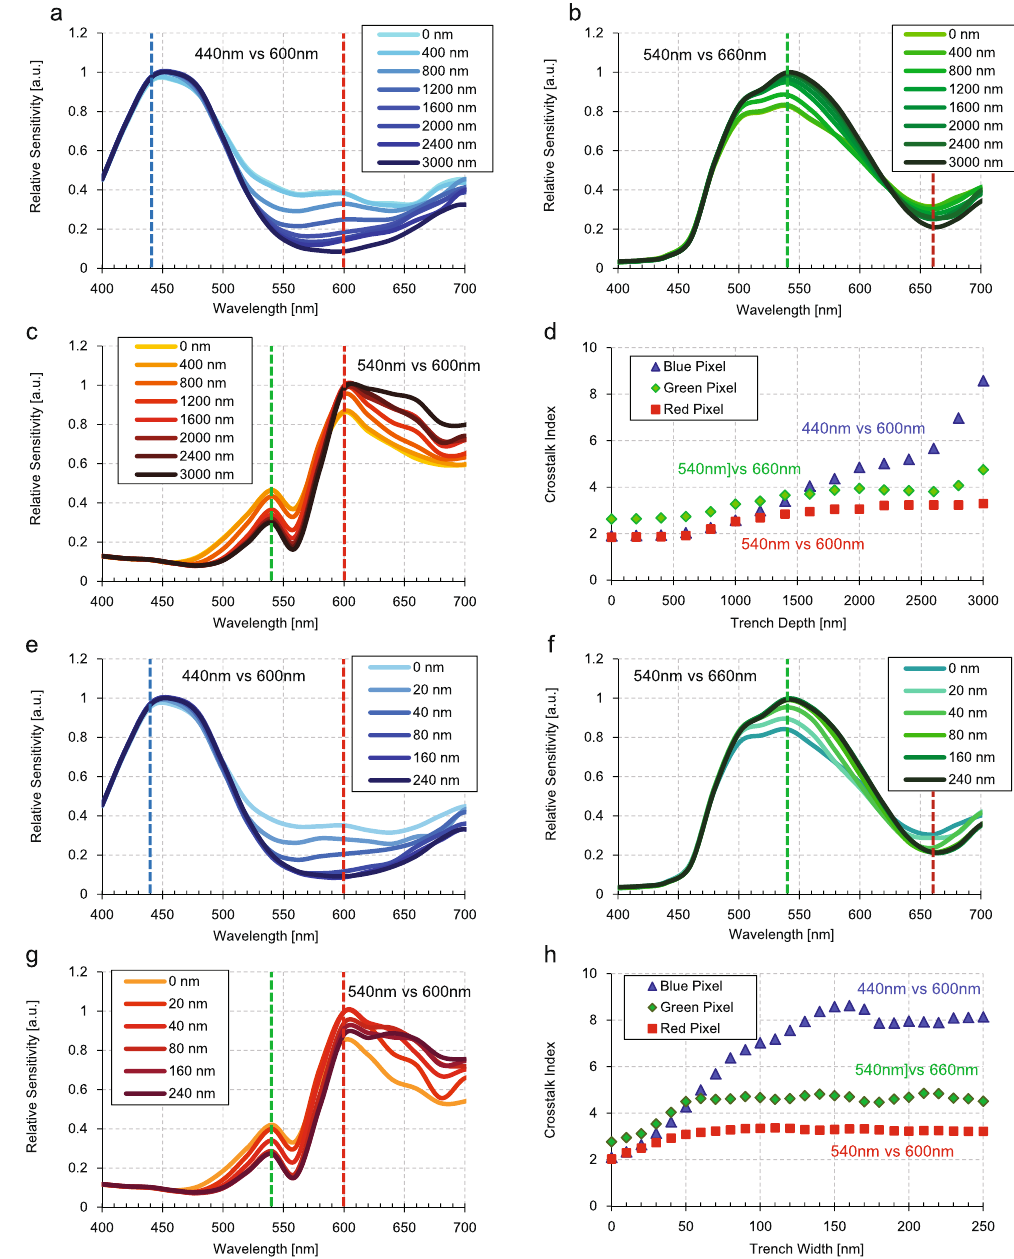
Figure 8. ( a – c ) These panels show the simulated spectral sensitivities of RGB pixels of sample C changing DTI depth from 0 nm (without DTI) to 3000 nm (DTI penetrate the substrate) in steps of 400 nm. ( a ) Shows the spectral sensitivity of blue pixel, ( b ) is that of green pixel, and ( c ) is that of red pixel. ( d ) This panel shows the spectral color ratio as index of photonic color crosstalk to adjacent pixels. Blue triangles are the ratio between 440 nm and 600 nm in blue pixel from ( a ), green diamonds are the ratio between 540 nm and 660 nm in green pixel from ( b ), and red squares are the ratio between 600 nm and 540 nm in red pixel from ( c ). ( e – g ) Show the same simulation results but changing DTI width from 0 nm to 240 nm with fixed depth of 3000 nm. ( e ) is for the blue pixel, ( f ) is for the green pixel, and ( g ) is for the red pixel. ( h ) This panel shows the spectral color ratio derived from ( e – g ) plotted in same fashion as panel ( d